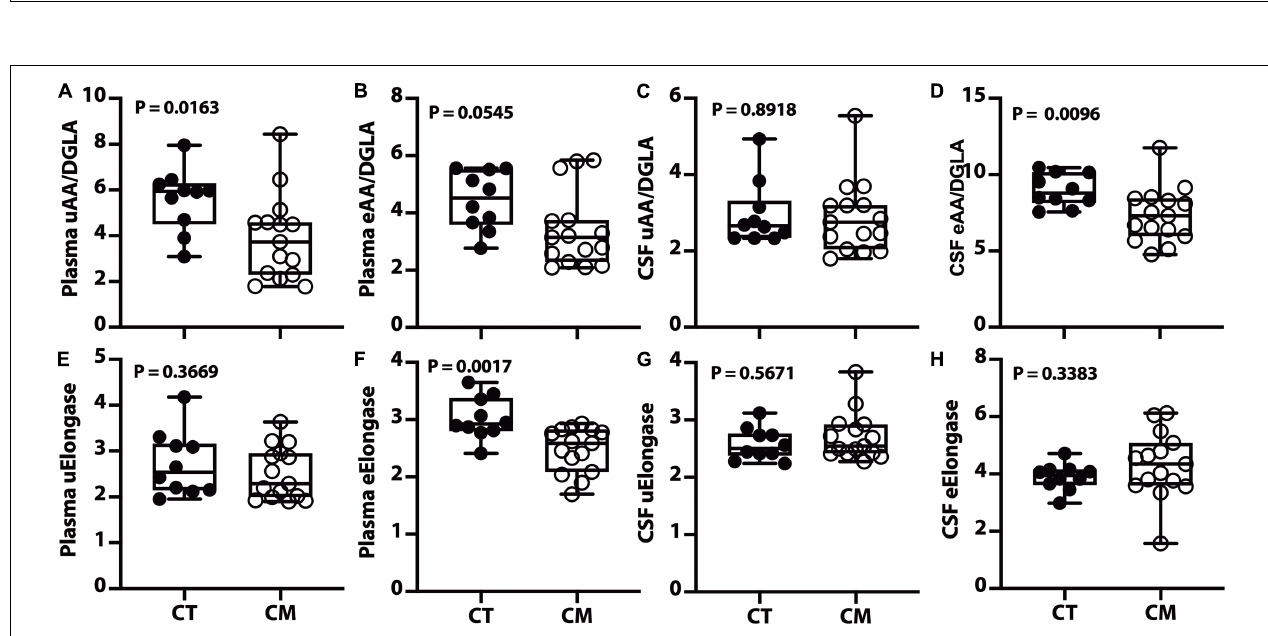
FIGURE 5 | Desaturase and elongase changes in plasma and CSF – Box and Whisker plots of plasma unesterified AA/DGLA (A) , plasma esterified AA/DGLA (B) , CSF unesterified AA/DGLA (C) , and CSF esterified AA/DGLA (D) . Violin plots of plasma unesterified elongase index [uElongase, (E) ], plasma esterified elongase index [eElongase, (F) ], CSF unesterified uElongase (G) , and CSF eElongase (H) . The p values were determined using a Mann–Whitney U test.